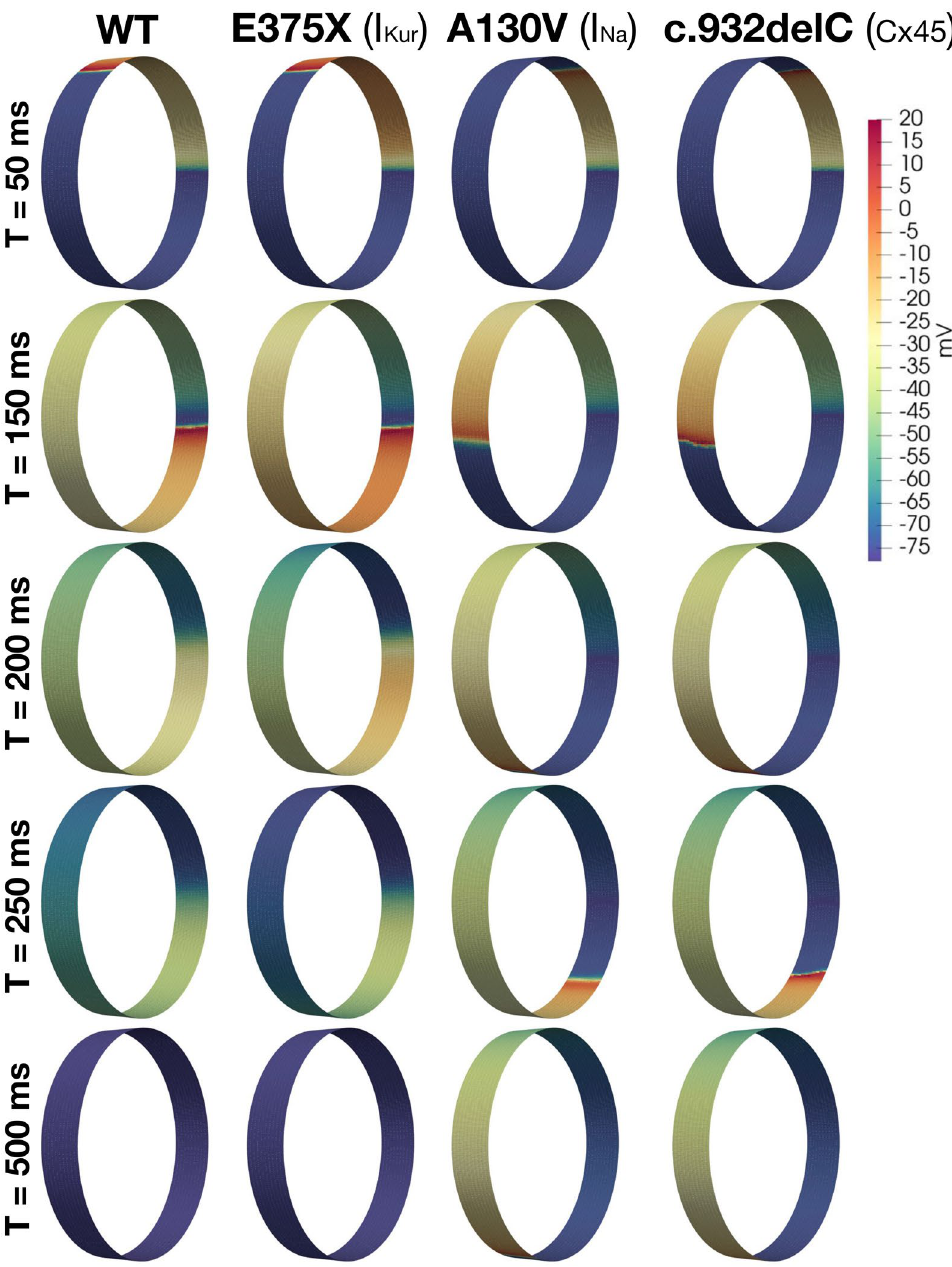
Figure 9. EMI-based multicellular simulations for WT, and for the E375X, A130V, and c.932delC mutations. The format of the figure is analogous to that of Fig.